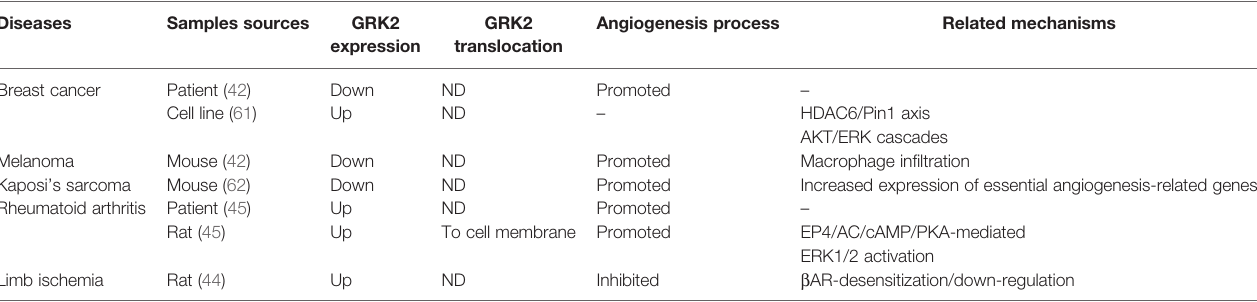
TABLE 1 | Correlation between GRK2 expression and translocation to pathological angiogenesis.